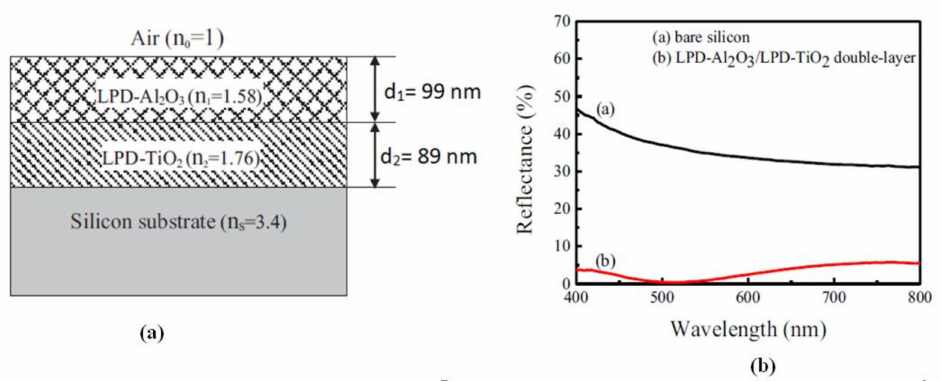
Figure 25. ( a ) Structural diagram of double layer LPD-Al 2 O 3 / LPD-TiO 2 ARCs. ( b ) Variation of measured reflectance for the LPD-Al 2 O 3 / LPD-TiO 2 DLARCs on polished silicon substrate and bare silicon. Reprinted with permission [238]; 2015,